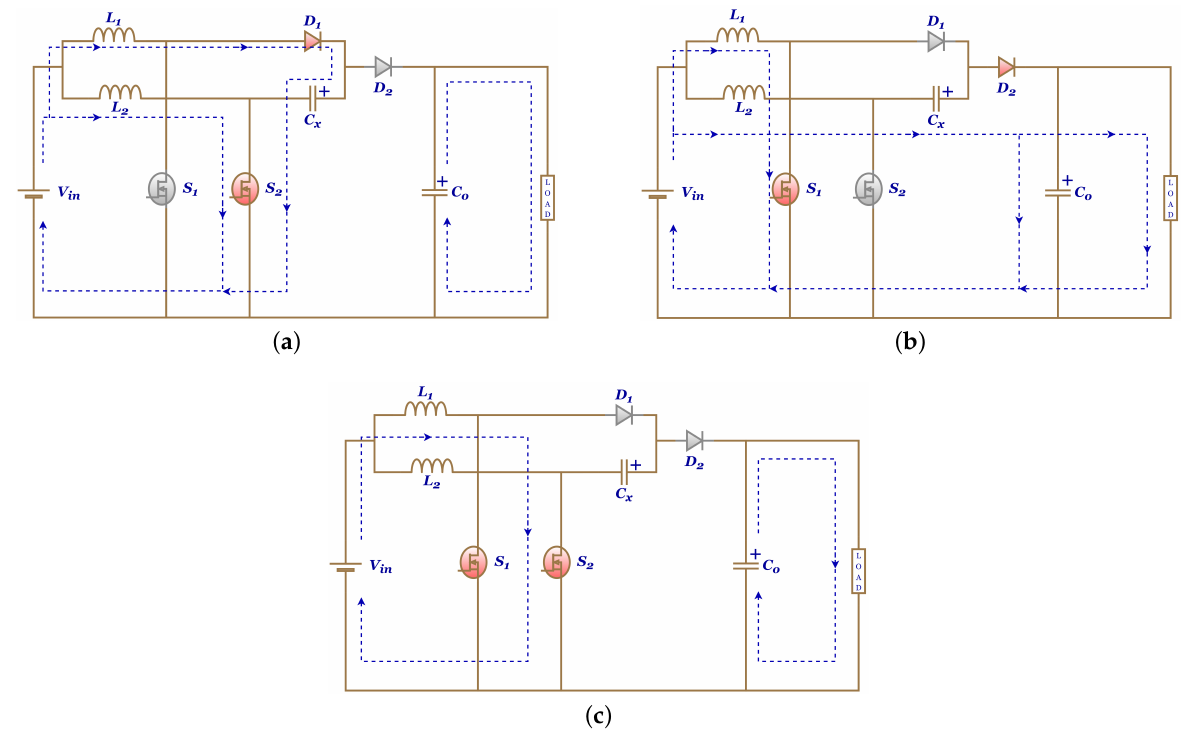
Figure 13. 1st M-IBC operation: ( a ) S 2 closed, ( b ) S 1 closed, and ( c ) S 1 and S 2